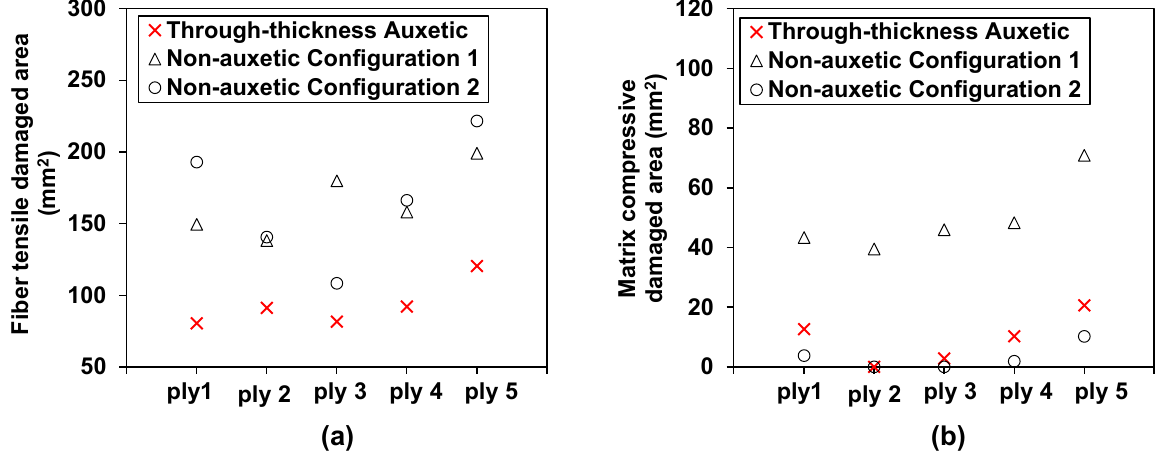
Figure 12. Effect of the through-thickness negative Poisson’s ratio on the fiber tensile damage and matrix compressive damage: comparison of the predicted damage areas in each ply of the auxetic laminate and the corresponding non-auxetic CFRP composite laminates at an impact energy of 8 J: ( a ) fiber tensile damaged area and ( b ) matrix compressive damaged area.